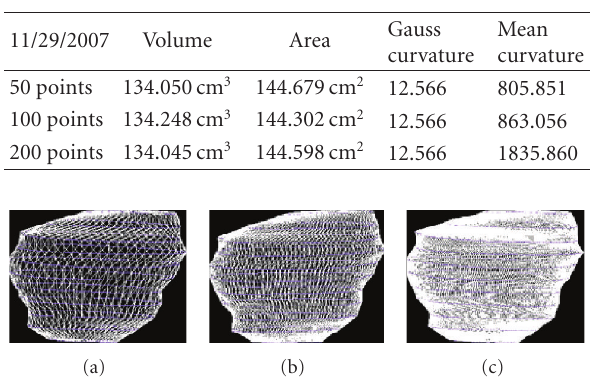
Figure 35: Patient 2. Evolution of the tumor with respect to